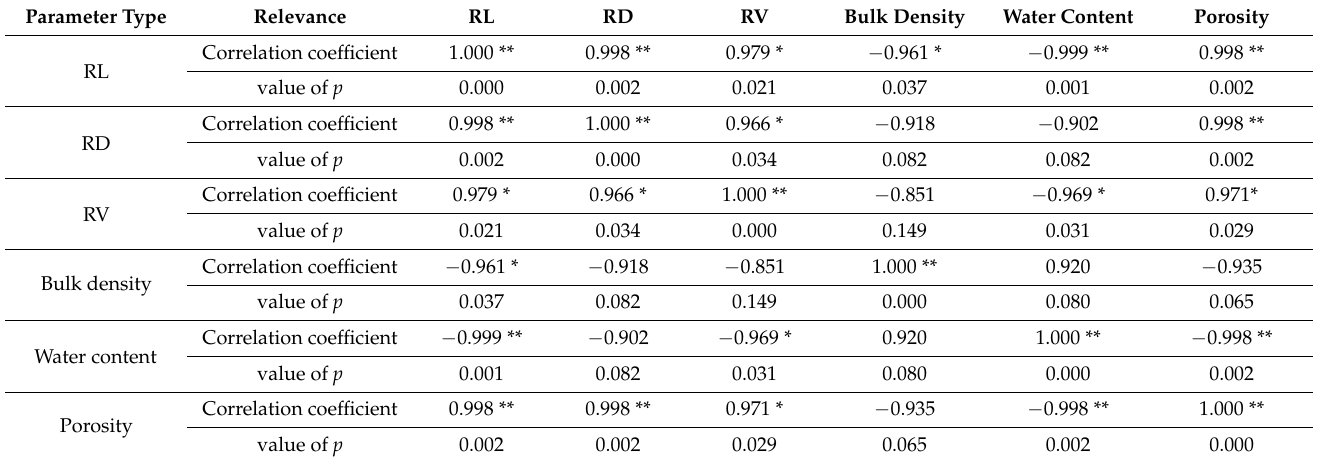
Table 5. Linear correlation results (* p < 0.05 ** p < 0.01).